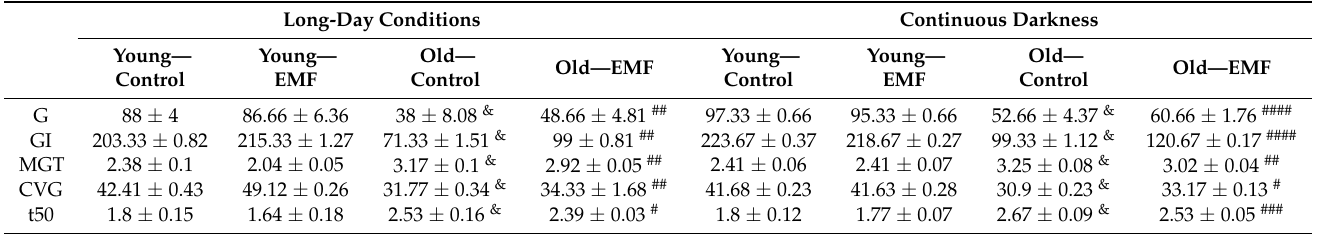
Table 1. The effects of EMF on germination parameters of field bean seeds cultivated in Petri dishes for 6 days under long-day conditions and in continuous darkness.